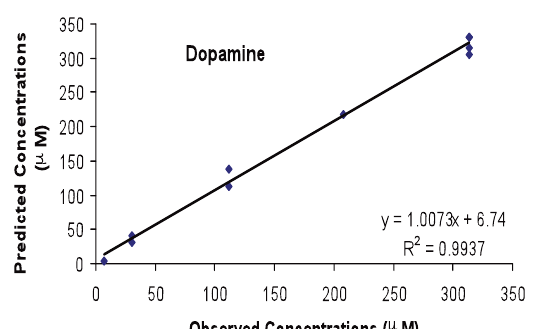
Figure 5. Cyclic voltammograms of DA (84 µM), AA (850 µM) and UA (65.5 µM) and mixture (120 µM DA, 1055 µM AA and 180 µM UA) at a bare glassy carbon electrode in 0.1 M pH 7 phosphate buffer, step potential = 2.5 mV, Scan rate = 100 mV s -1 .